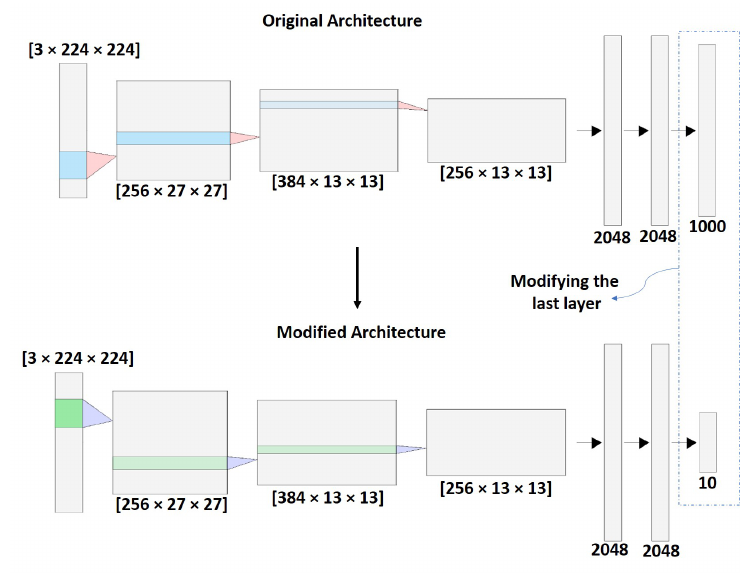
Figure 4. Example of transfer Learning in a sequential CNN by replacing the last layer. Numbers in square brackets correspond to [Channels × Height × Width]. It was generated using NN-SVG